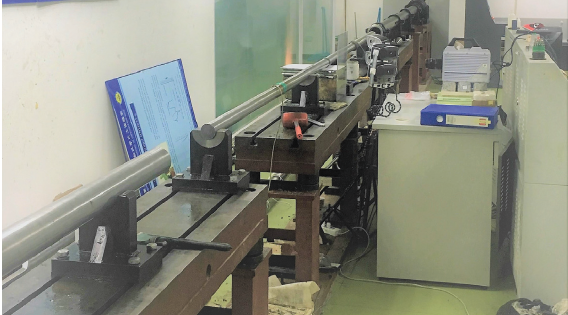
Figure 2: Physical map of the SHPB experimental